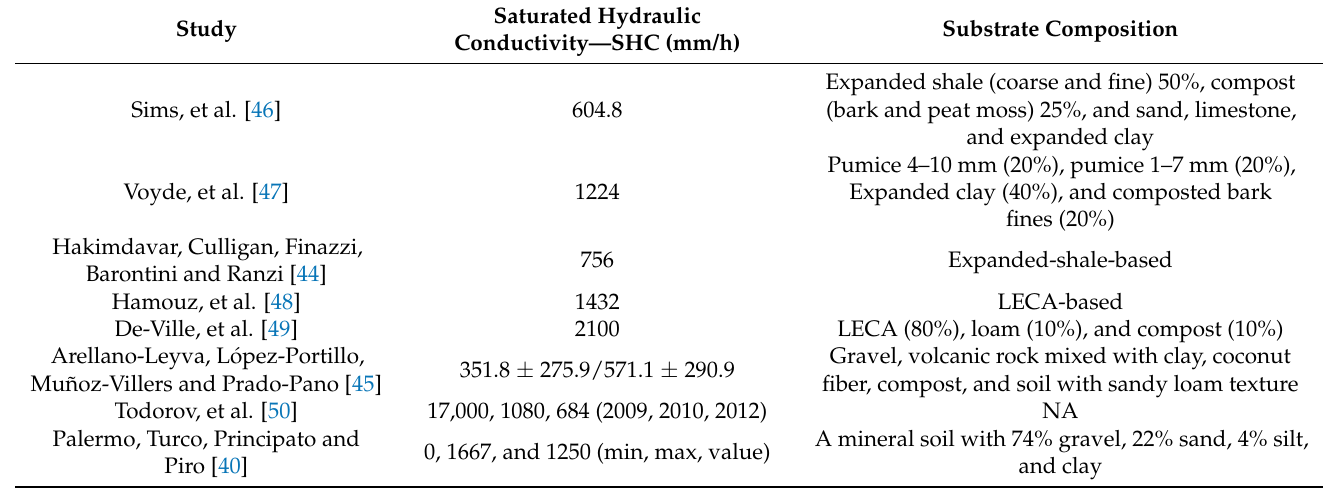
Table 5. Saturated hydraulic conductivity values for different substrate types as reported in the